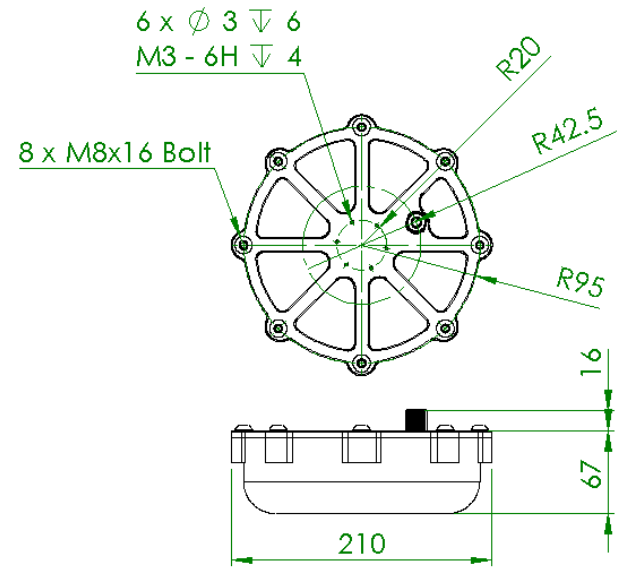
Figure 7. WCH final design general dimensions.